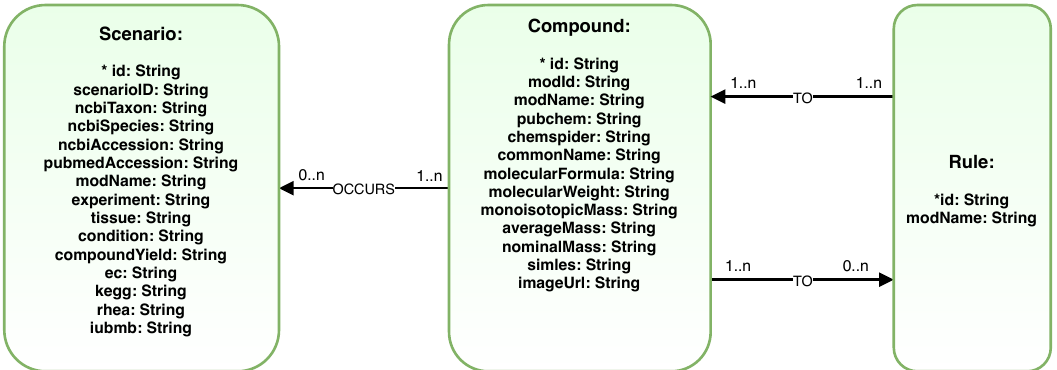
Figure 10. A 2Path-Sesquiterpenes database scheme: Each Compound can be related to zero or more Rules. Each Rule needs to be related to one or more Compound. Each Compound can be related to zero or more